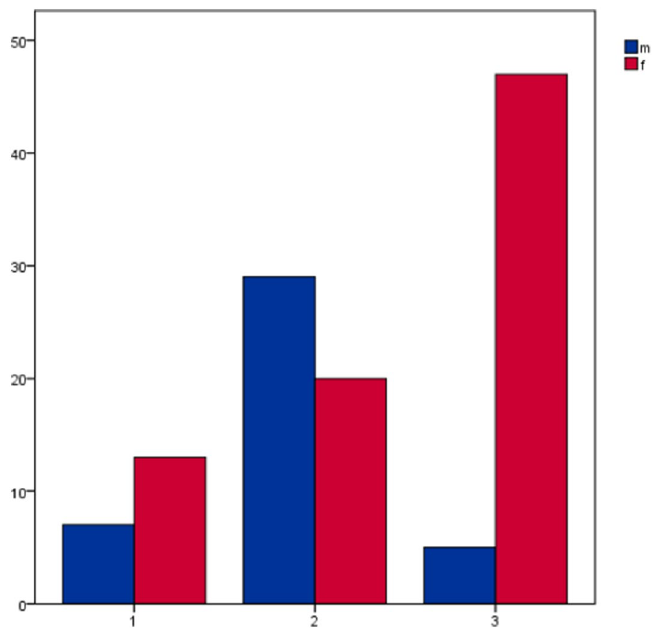
Figure 4. Samples with undesired cortical screw perforation, the figure shows distribution across the three defined zones in relation to sex; x-axis shows the area of cortical perforation (group 1 = perforation along the pubic ramus; group 2 = perforation of the acetabular joint surface; group 3 = perforation along the pubic ramus and the acetabular joint surface), y-axis shows the number of samples.